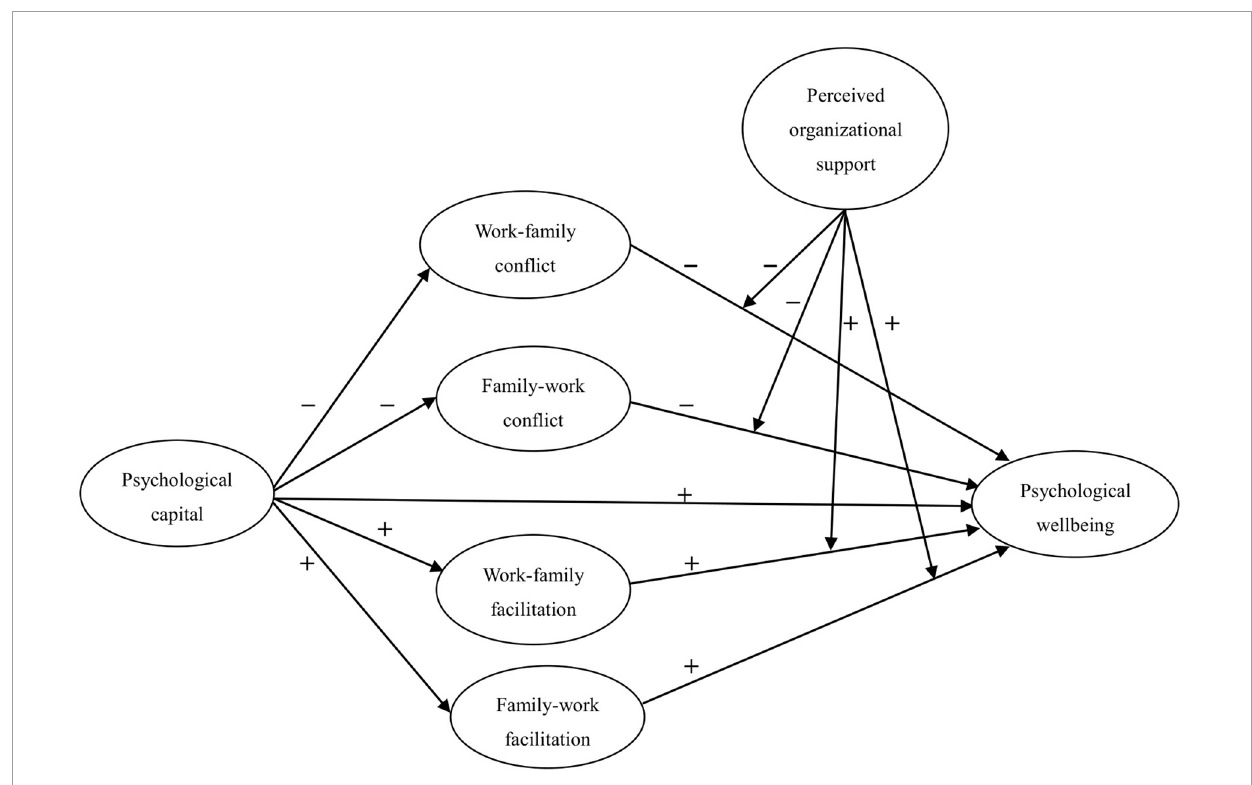
FIGURE1 Conceptual model for the